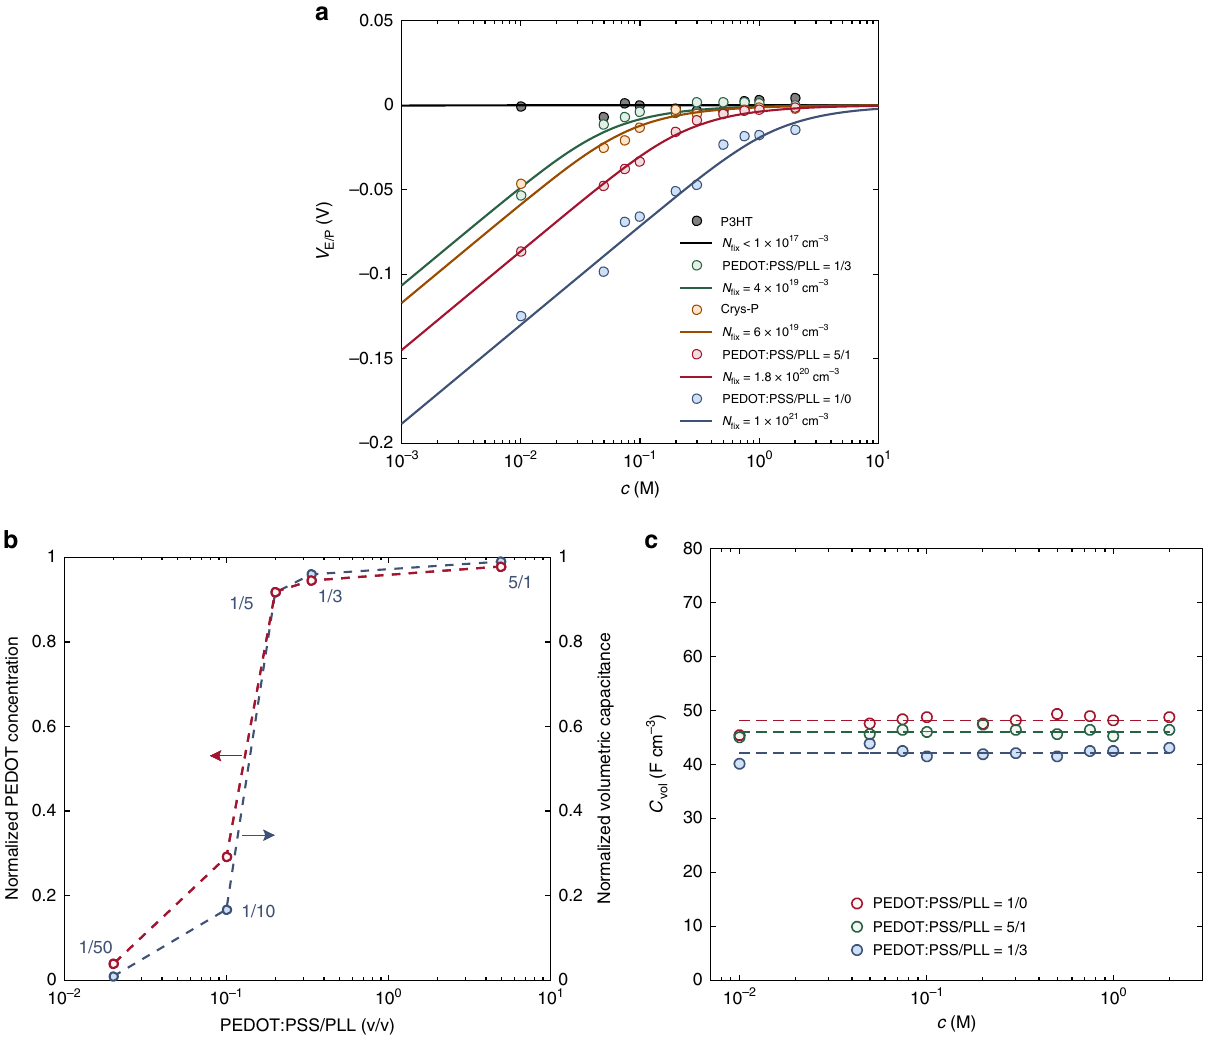
Fig. 6 The effect of bulk and interface charge. a Measured (symbols) and calculated (solid lines, Eq. (6)) V E/P as a function of c in OECTs with various polymeric channels. b PEDOT concentration (red symbols, left axis) and volumetric capacitance C v (blue symbols, right axis) of PEDOT:PSS:PLL OECTs as a function of the PEDOT:PSS/PLL ratio. The C v is normalized to the C v of pristine PEDOT:PSS. Analogously, the PEDOT concentration is normalized to the PEDOT concentration of PEDOT:PSS OECTs. The dashed lines are guide for the eye. c Measured C v as a function of c for OECTs with various PEDOT:PSS/ PLL ratio (symbols). The dashed lines are the mean